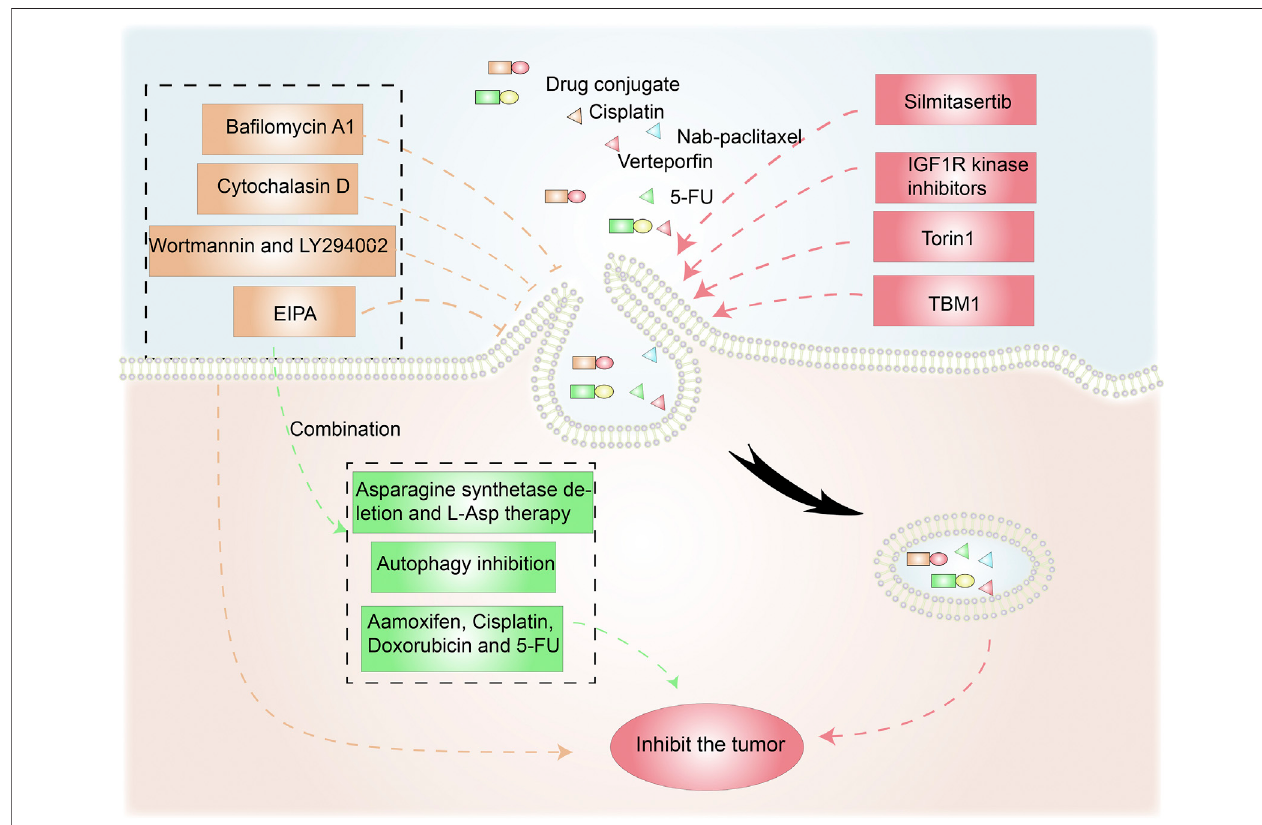
FIGURE 5 | Anticancer therapies targeting macropinocytosis. Drug conjugates containing compounds that activate macropinocytosis in addition to anticancer drugs promote cancer treatment. Moreover, macropinocytosis-initiating drugs combined with nab-paclitaxel or vertepor fi n inhibit tumor cells. Macropinocytosis inhibitors such as cytochalasin D, Wortmannin/LY290042, and EIPA can affect tumor survival and drug resistance. EIPA combined with asparagine depletion and tamoxifen etc . can have synergistic antitumor effects.